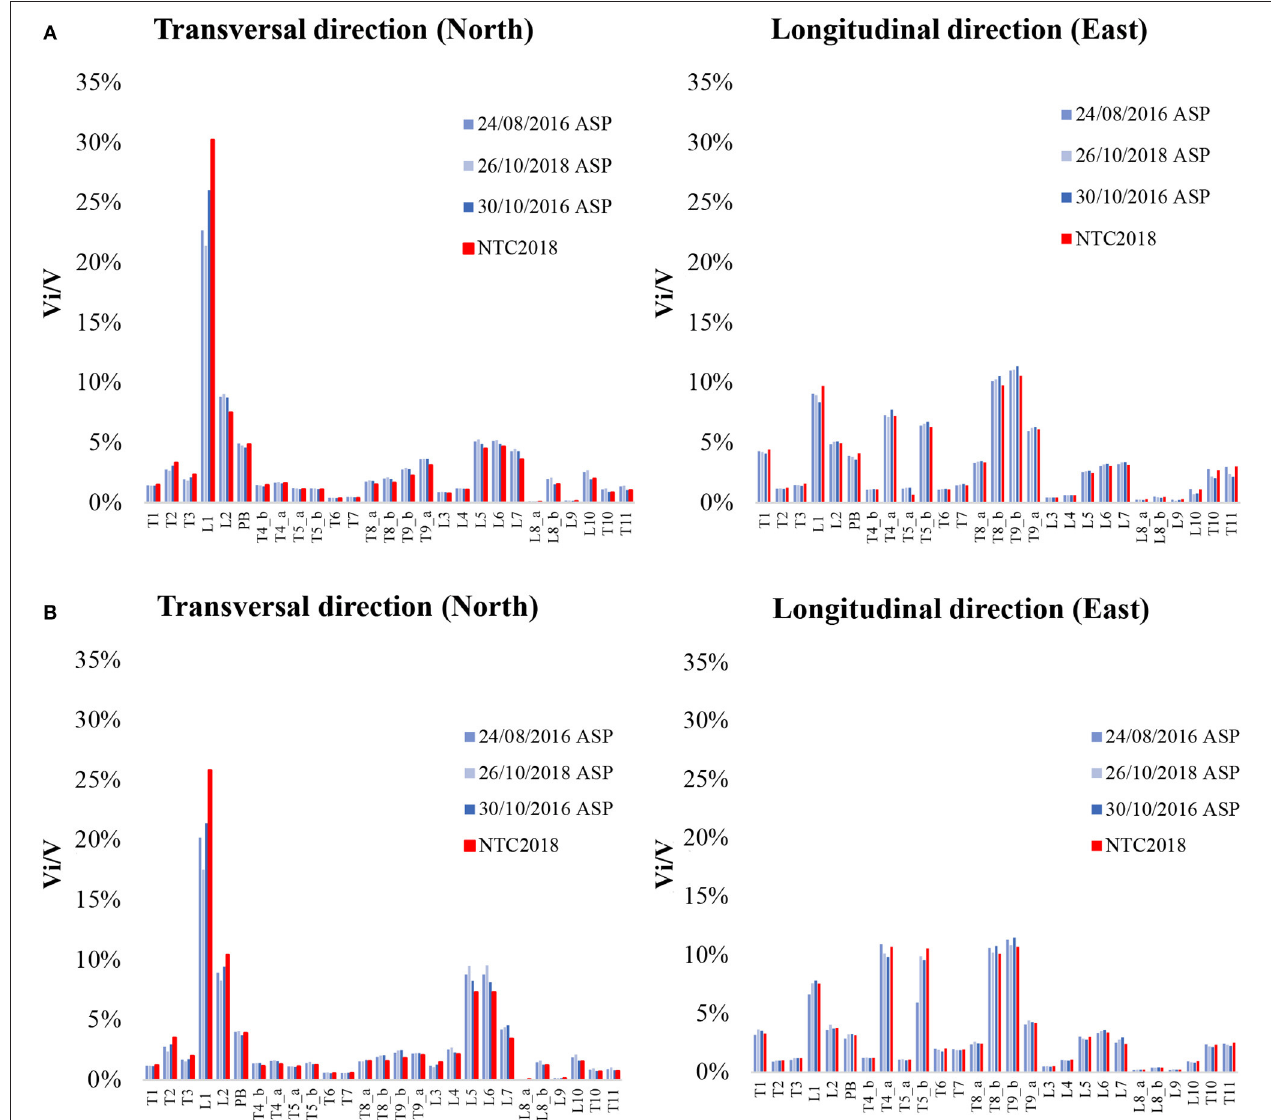
FIGURE 9 | Distribution of base shear among macro-elements in longitudinal and transversal direction for the Model CS (A) Model DF (B) .